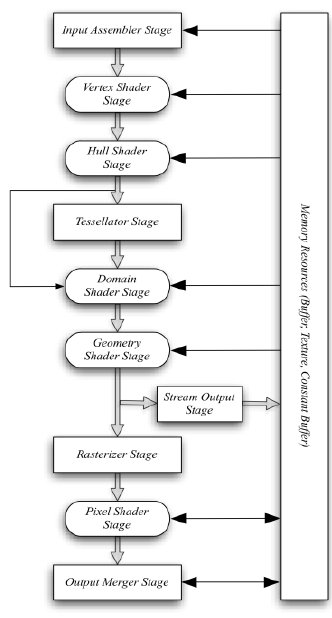
Figure 10. The graphics pipeline in Shader Model